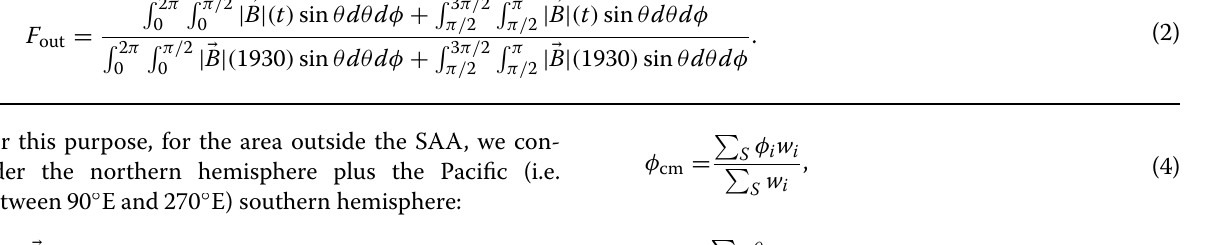
ilar to (3), we calculate